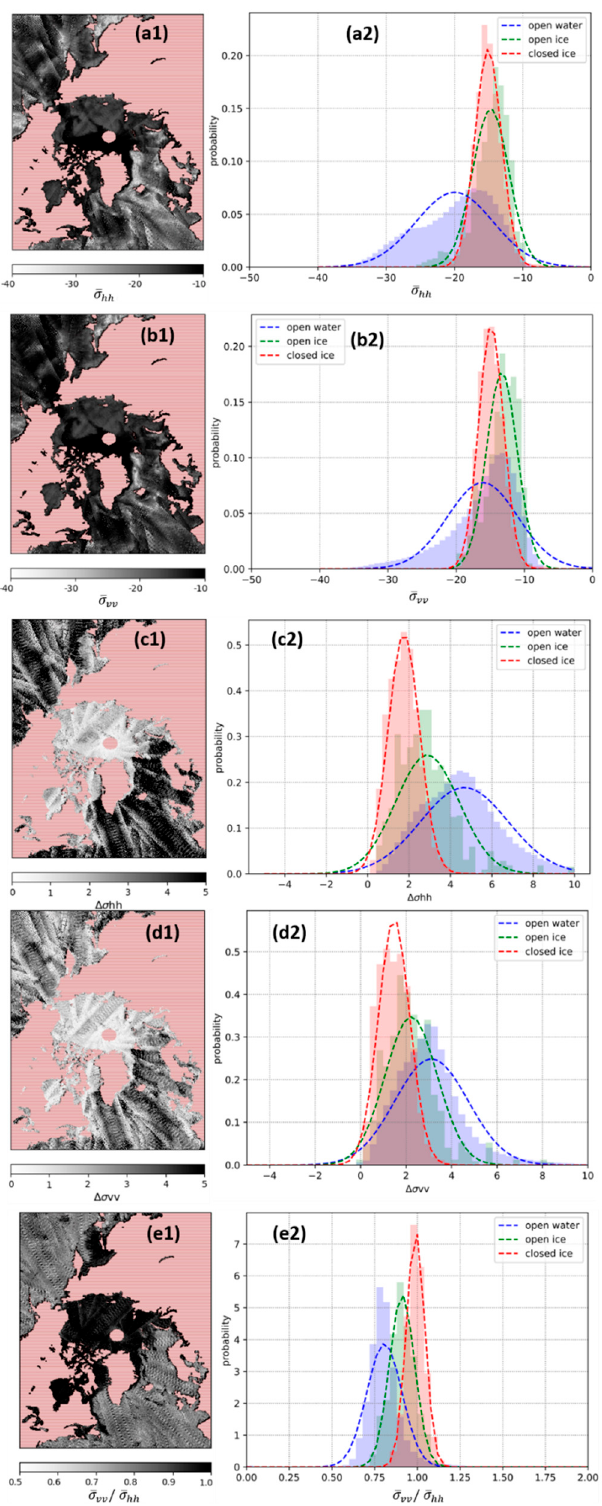
Figure 4. Parameters derived from one day of CSCAT measurements in the Arctic on 7 March 2019. ( a1 ) σ hh , ( b1 ) σ vv , ( c1 ) ∆ σ hh , ( d1 ) ∆ σ vv and ( e1 ) γ . Arctic images contain 448 × 304 pixels with a pixel resolution of 25 km. The central white circular area represents no observations. Density plot for parameters ( a2 ) σ hh , ( b2 ) σ vv , ( c2 ) ∆ σ hh , ( d2 ) ∆ σ vv , and ( e2 ) γ for open water (blue), open ice (green), and closed ice (red).